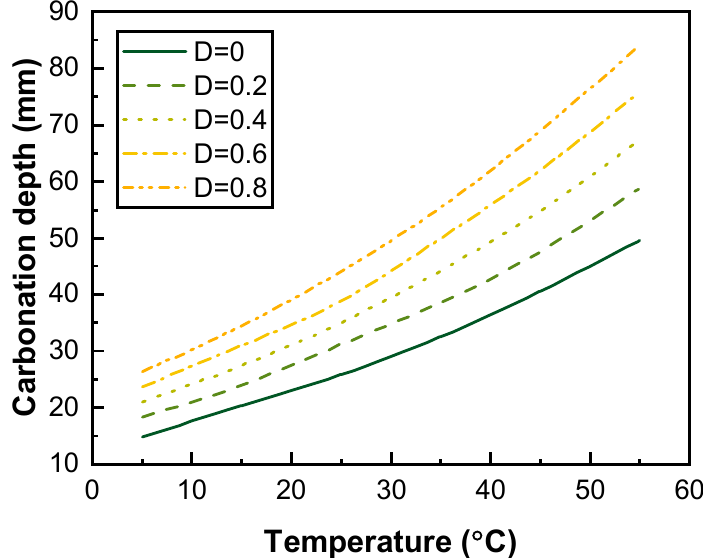
Figure 17. Effect of environmental temperature on the carbonation of fatigue-damaged RC beams. Figure 17. E ff ect of environmental temperature on the carbonation of fatigue-damaged RC